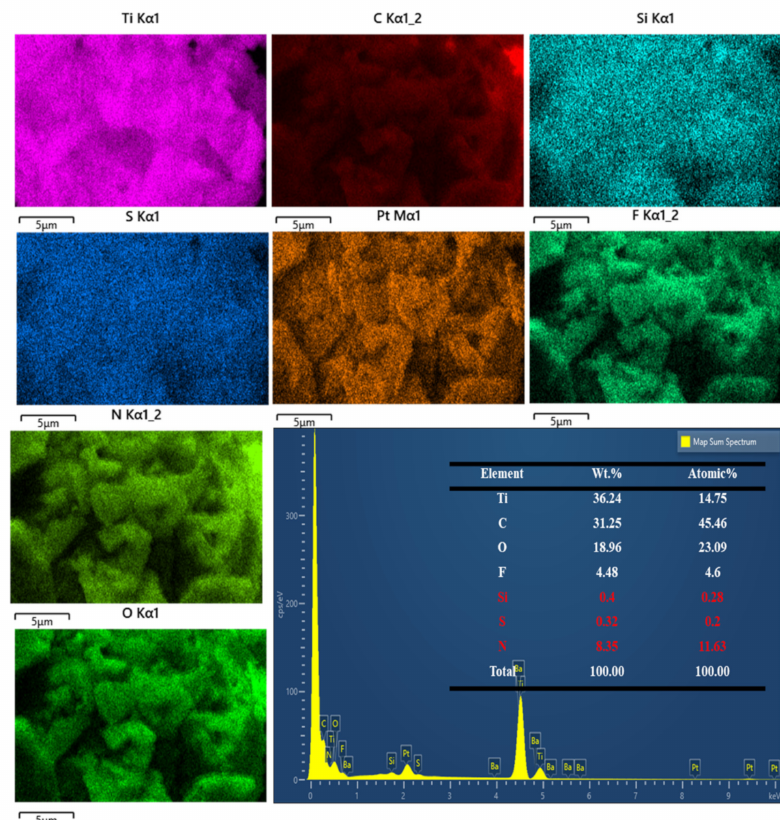
Figure 4. EDX mapping of the MXene − TK − DOX@PDA